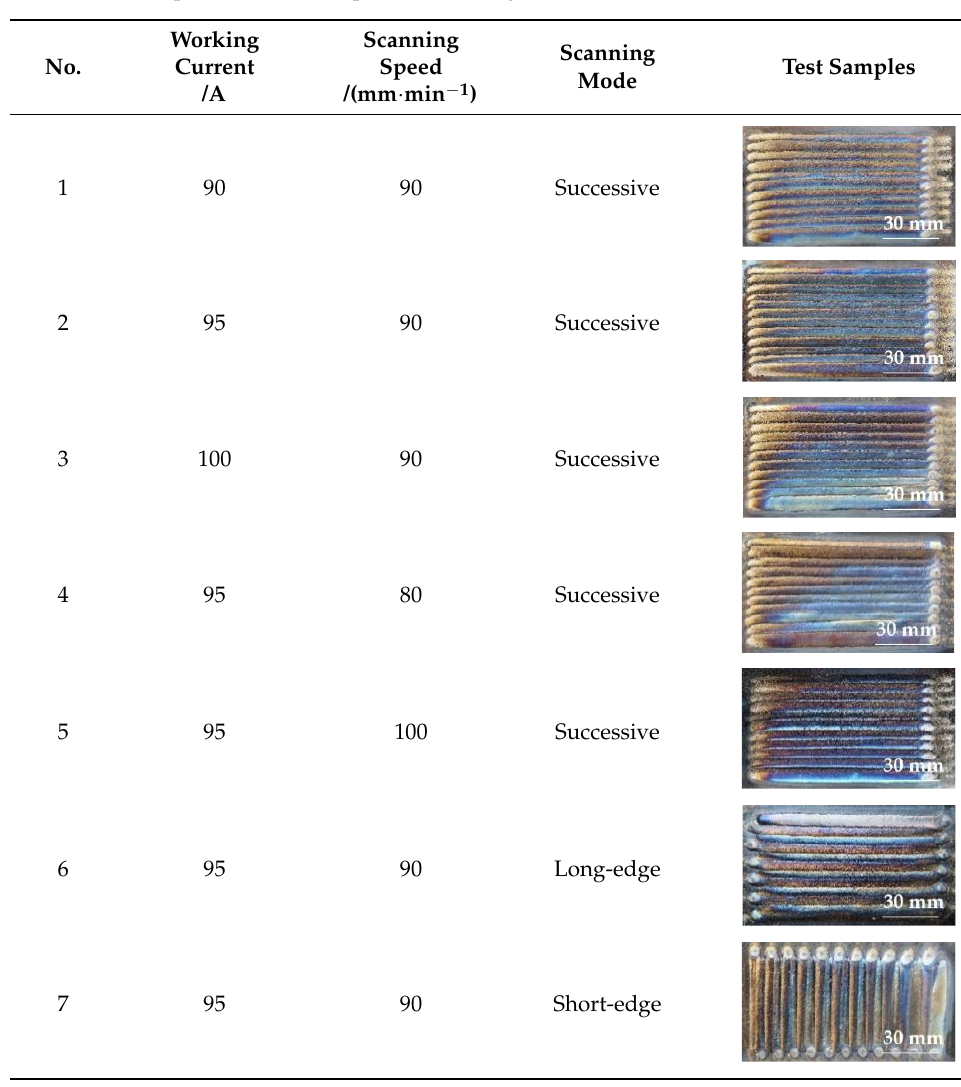
Table 3. Process parameters of the plasma cladding.